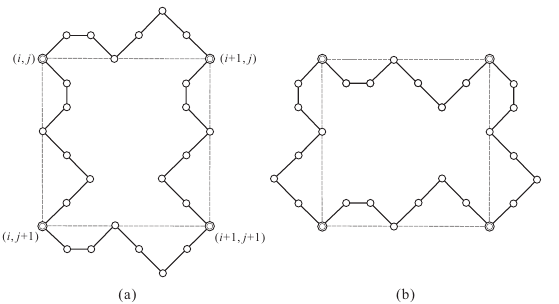
Figure 5. Arrangement of snake paths for a square ( i , j ) , ( i , j + 1 ) , ( i + 1, j ) , ( i + 1, j + 1 ) of G g , where ( a ) i , j are even or odd and ( b ) i is odd and j is even, or i is even and j is odd.